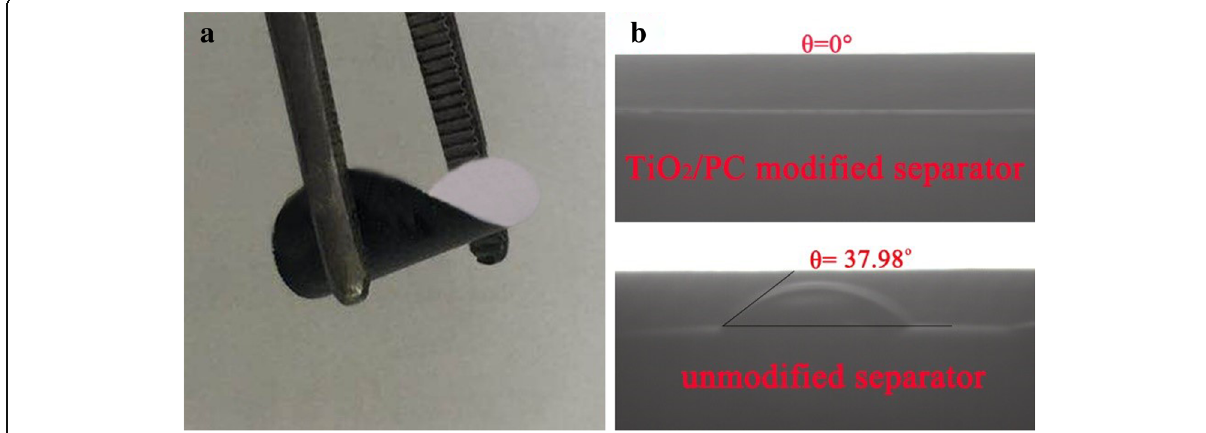
Fig. 6 Digital images of the TiO 2 /PC-modified separator with excellent flexibility. ( a ) The contact angle of the electrolyte on the surface of the TiO 2 /PC-modified separator and the unmodified separator ( b